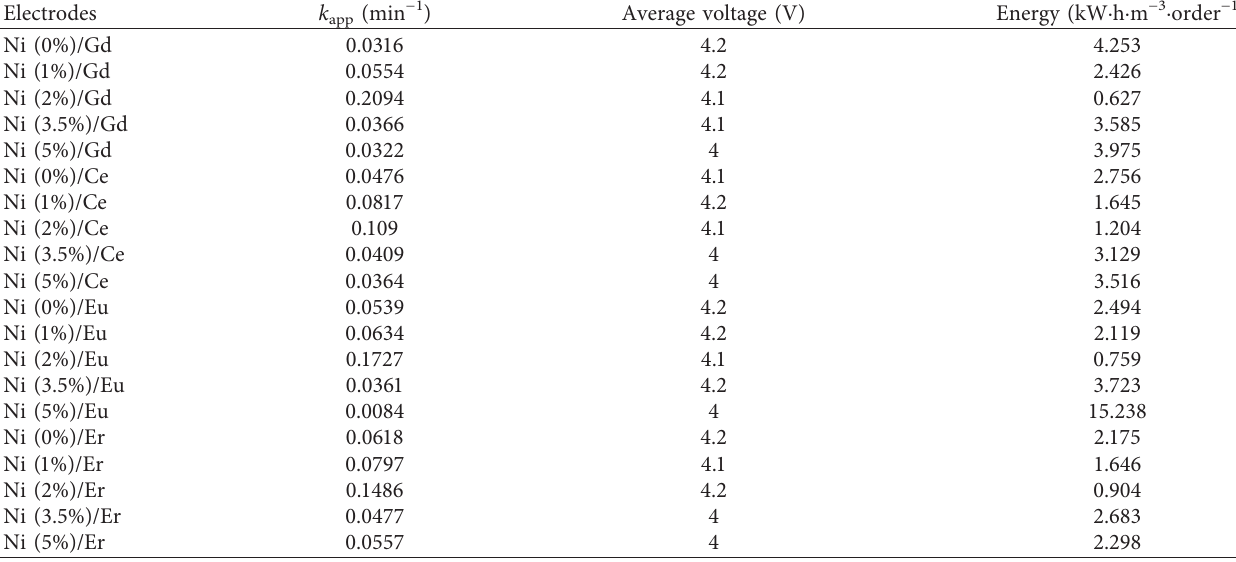
Table 11: Energy per order of decolorized 20mg · L − 1 RhB solution, evaluated from equation (5), and electrochemical decolorization of Ti/ SnO 2 -Sb-Ni/Re electrodes with various Ni contents and different rare earth elements in 200ml dye solution. Electrodes